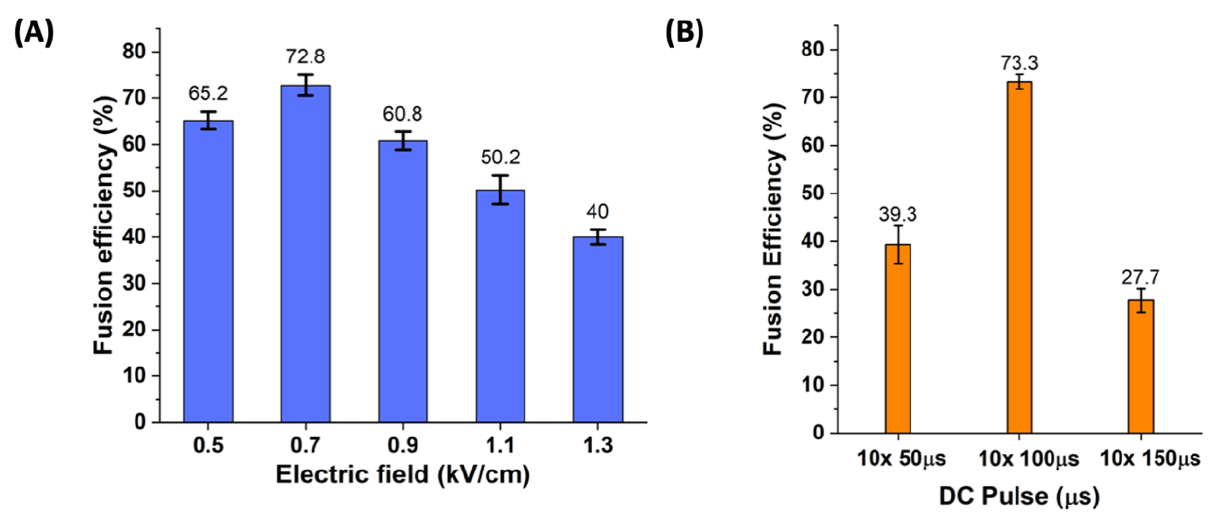
Figure 5. Effect of electric field on fusion efficiency ( A ) The maximum fusion efficiency of 72.8% was achieved when the electric field strength was 0.7 kV/cm. ( B ) The effect of the duration of DC pulses applied was also studied. The DC pulse duration varied from 50 µ s to 150 µ s. The number of pulses was fixed to 10. The highest fusion efficiency was observed when the duration of the pulse was 100 µ s. Error bars, mean ± s.d., ( n = 3) ( p <